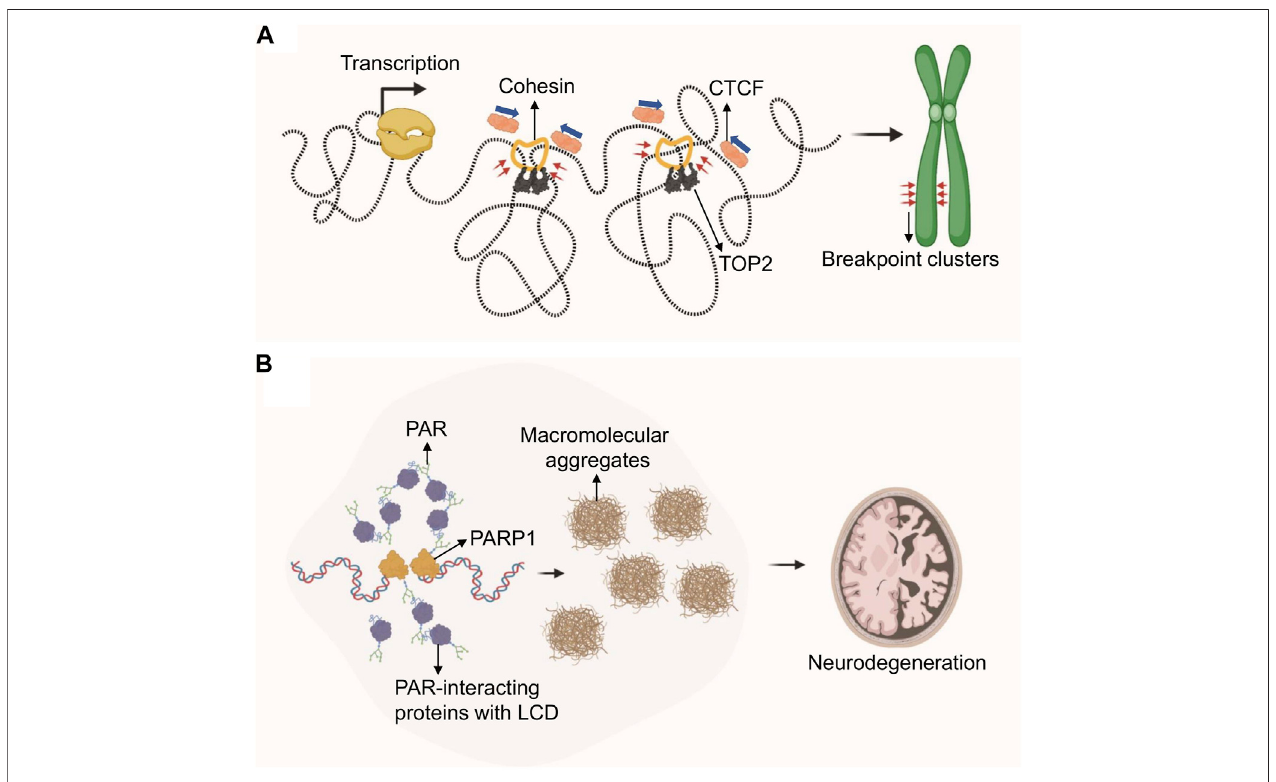
FIGURE 4 | Role of genome architecture in genome instability and disease. (A) Loop extrusion by cohesin creates tortional stress on DNA, which is relieved by topoisomerases. TOP2 inhibition via etoposide covalently traps TOP2 at TAD boundaries which generates DSBs in the presence of transcription, ultimately resulting in chromosomal translocations. Etoposide – treatment in cancer is frequently associated with recurrent chromosomal translocations at TAD-boundary-associated breakpoint clusters. (B) DNA damage-driven, protein-rich biomolecular condensates are linked to neurodegeneration in A-T or ATLD patients. DDR defects in these patients cause PARP1 hyperactivation and PAR chain accumulation. PAR-dependent protein aggregates are found in A-T patient